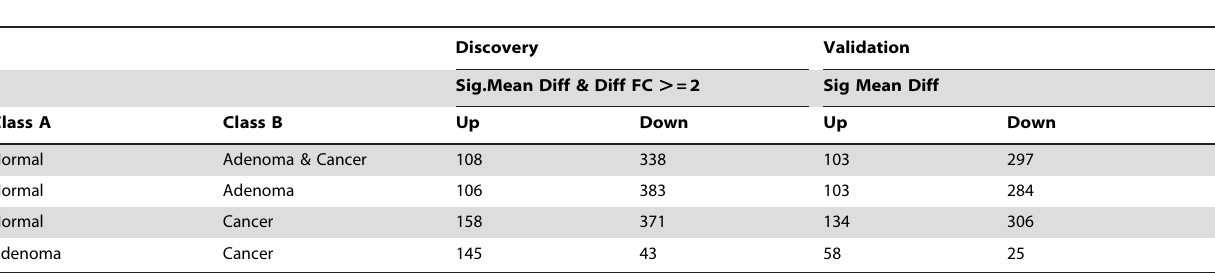
Table 2. Summary of microarray discovery and validation